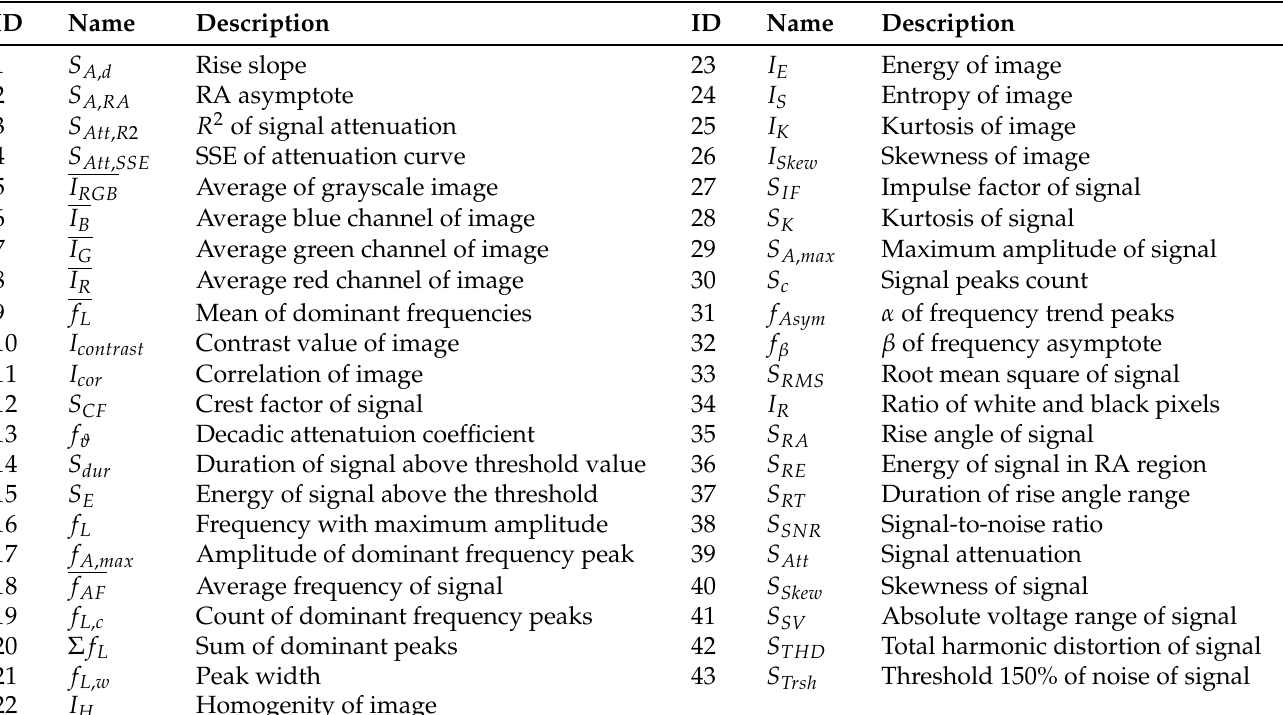
Table 3. List of all used features from signals and